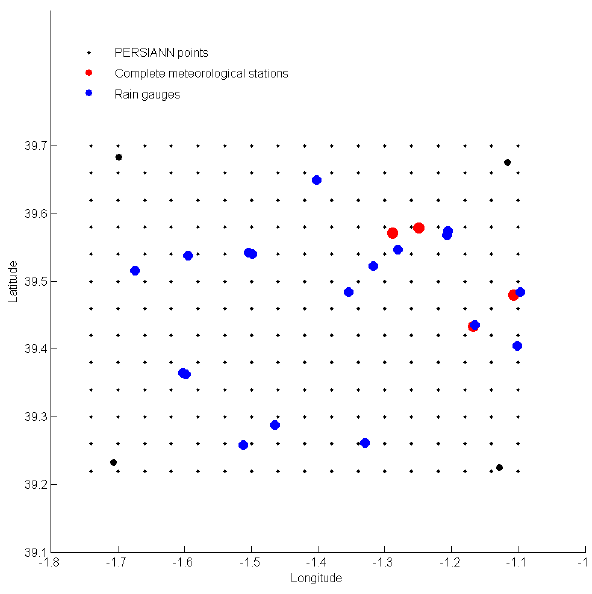
Fig. 1. Distribution of the in situ meteorological stations (red dots) and rain gauges (blue dots) over the 50 × 50km 2 VAS area (the four large black dots representing its limits). The PERSIANN points are represented in small black